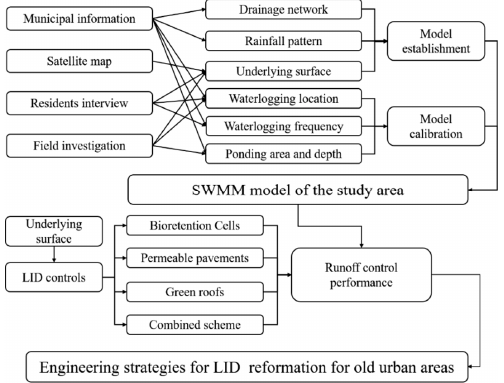
Figure 1. The methodology of this study.